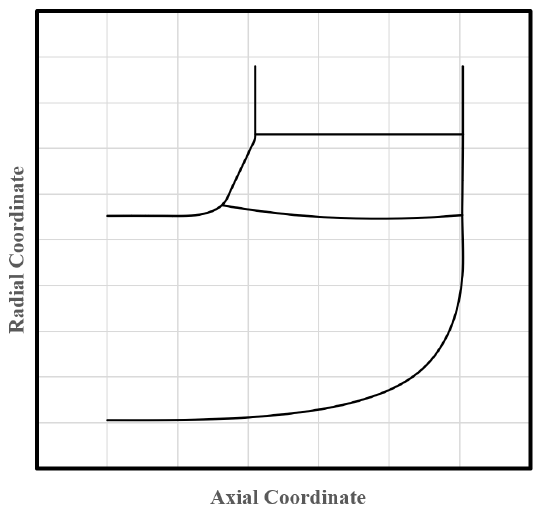
Figure 4. Baseline meridional